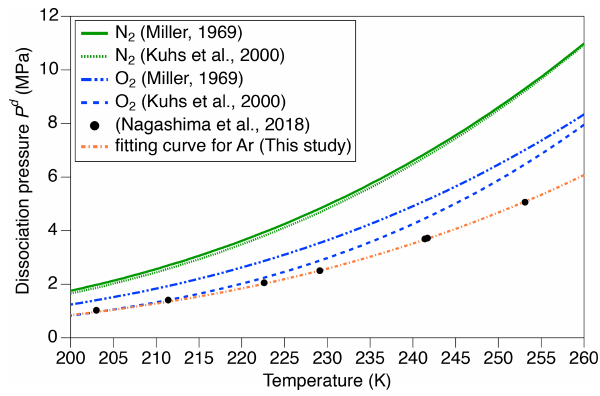
Figure A1. Relationship between temperature and dissociation pressure for N 2 , O 2 (Miller, 1969; Kuhs et al., 2000), and Ar hy- drates (Nagashima et al., 2018). The data for Ar hydrate (solid circles) are fitted with an exponential function: log P d = 3 . 63 − 739 . 5 /T .